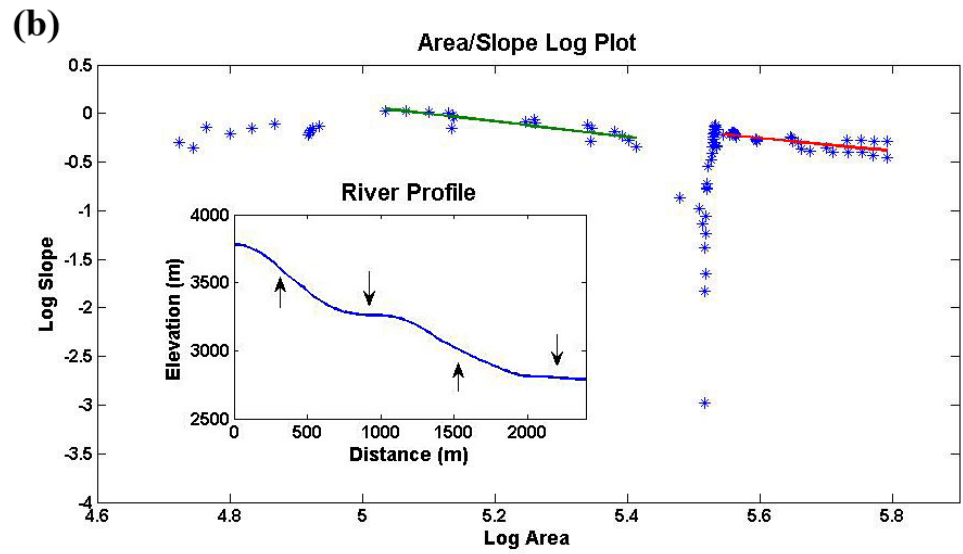
Figure 7. River elevation profiles and slope-area plots extracted from a 20 m ASTER DEM for two representative tributary types. ( a ) The example of a stream with one concave channel segment; ( b ) The example of a stream with two concave channel segments, one in the upper segment and another in the lower segment. The lines represent the linear regression fit. The arrows indicate the range of each concave segment. Table 1. Streams: Regression Fits, RMSE, Concavity ( θ ) and Logarithm Steepness ( log